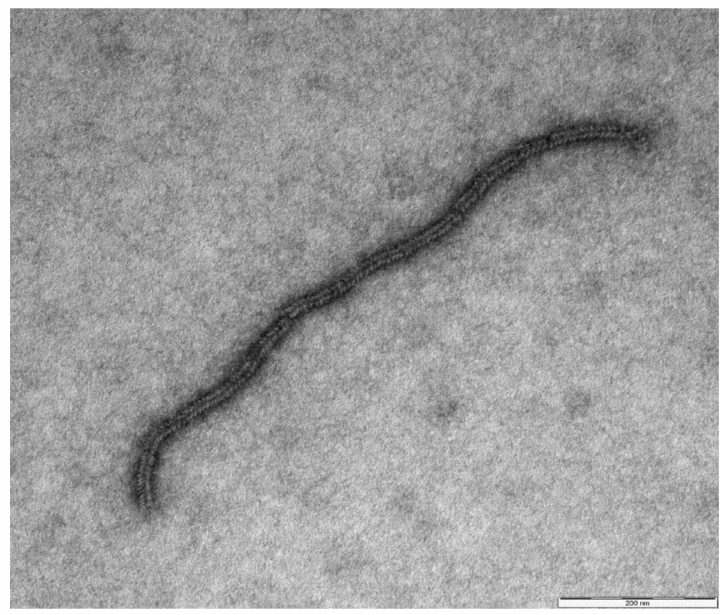
Figure 2. Long fragment of free nucleocapsid chains originating from the disintegration of respirovirus particles in the supernatant of a CPE-positive MDBK cell culture infected with ChamoisRV / IT2014. Negative staining electron microscopy (nsEM), NaPT 2%. Bar = 200